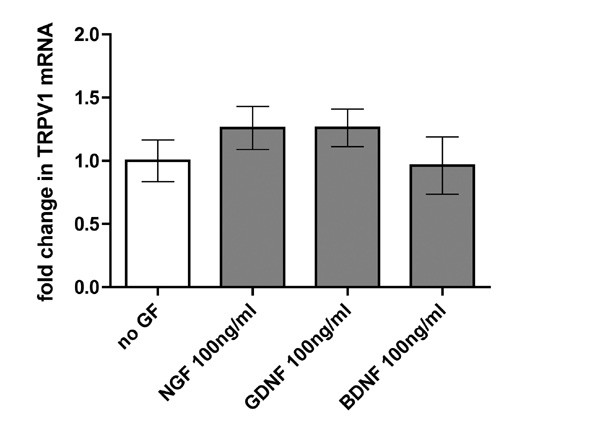
Assessment of TRPV1 mRNA levels by Realtime PCR. Levels of TRPV1 mRNA are depicted as fold change compared with no growth factor-treated cultures for each growth factor condition normalized to its corresponding GAPDH mRNA levels (n = 3).